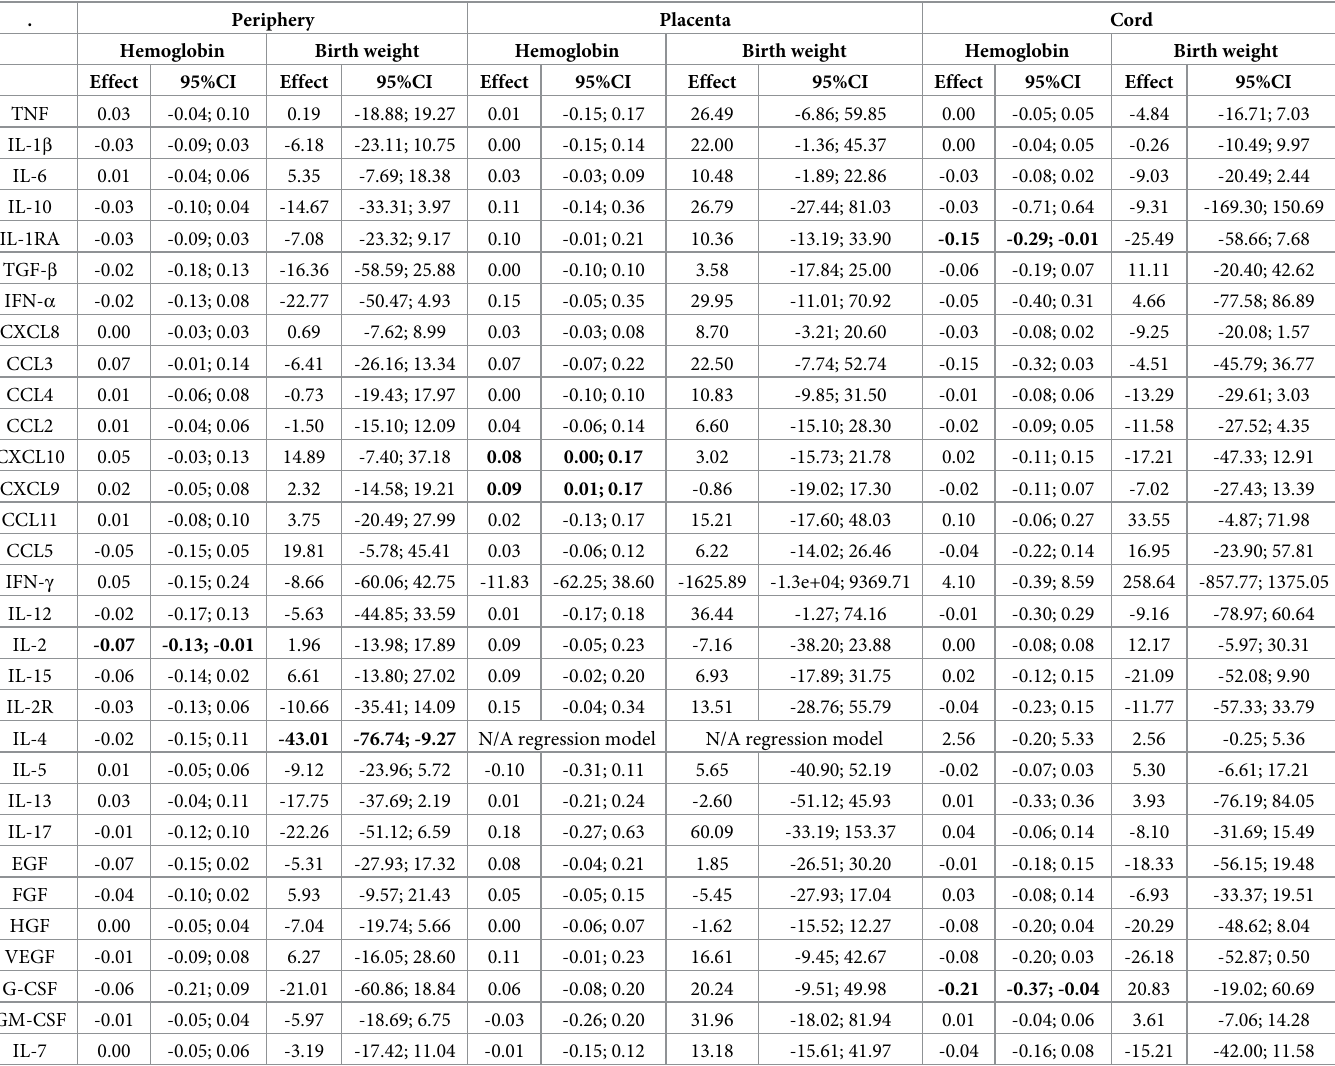
Table 6. Association of biomarkers at delivery with hemoglobin levels at delivery and birth